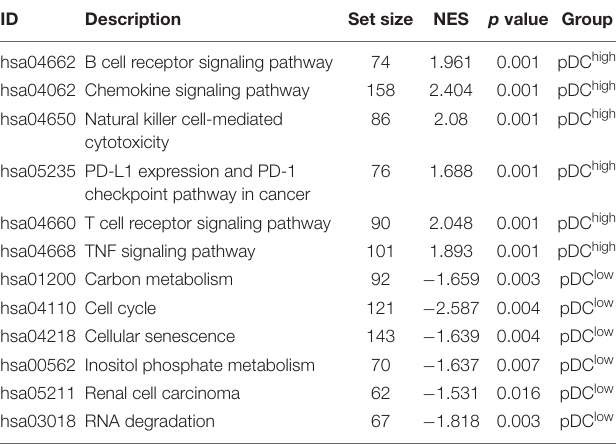
TABLE 2 | The enriched KEGG pathways associated with the pDC in TCGA.